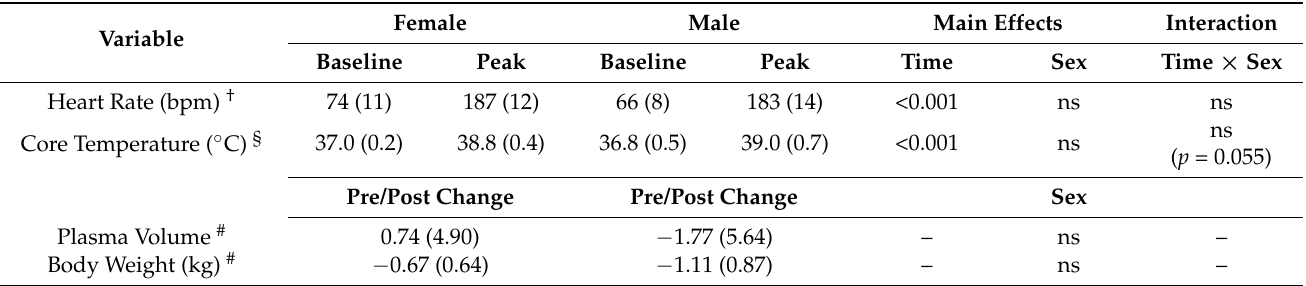
Table 2. Heart rate, core temperature, and hydration changes in responses to firefighting activities for male and female firefighters. Values presented as mean (standard deviation).